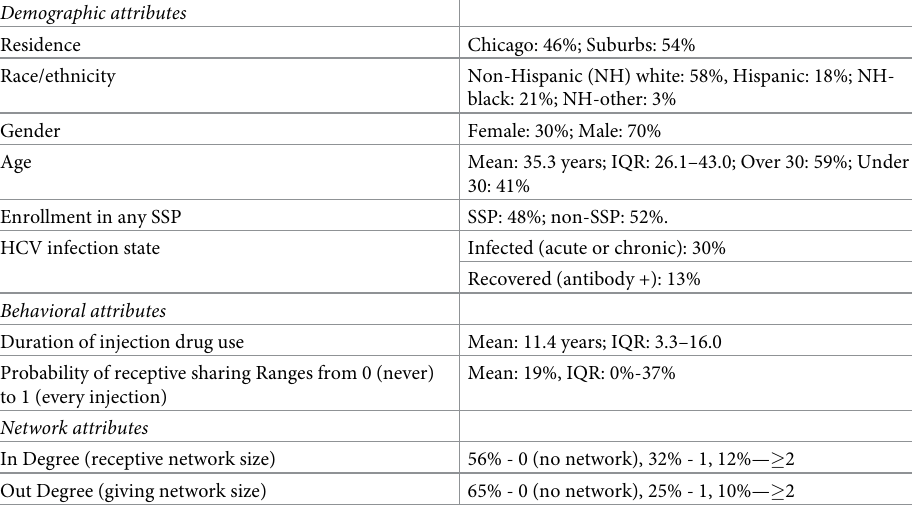
Table 1. Attributes of the synthetic population